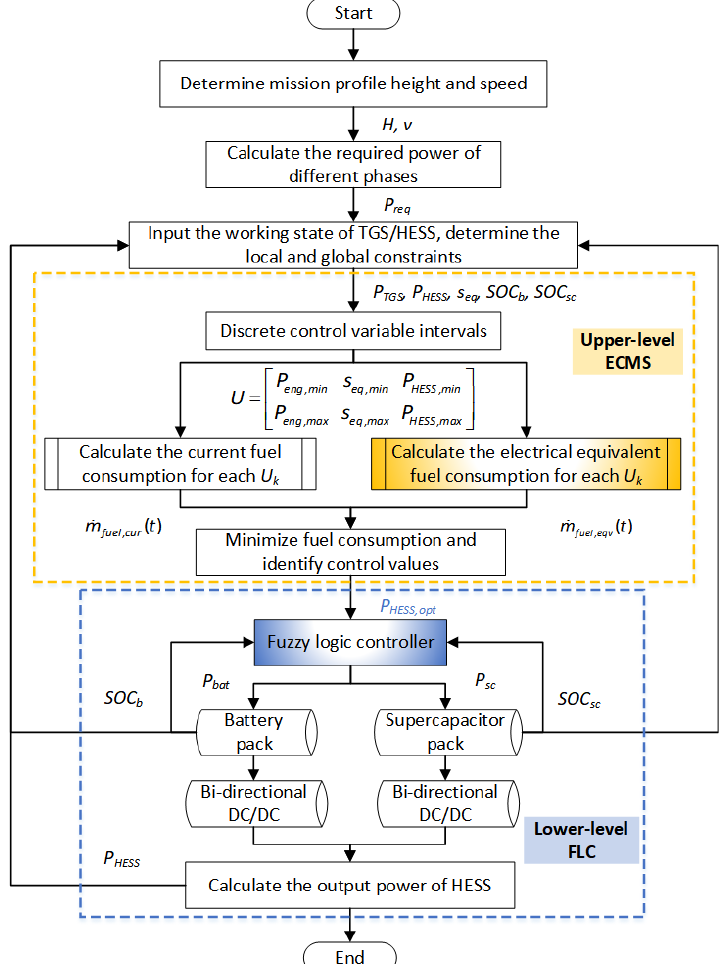
Figure 9. Hierarchical energy management framework of the